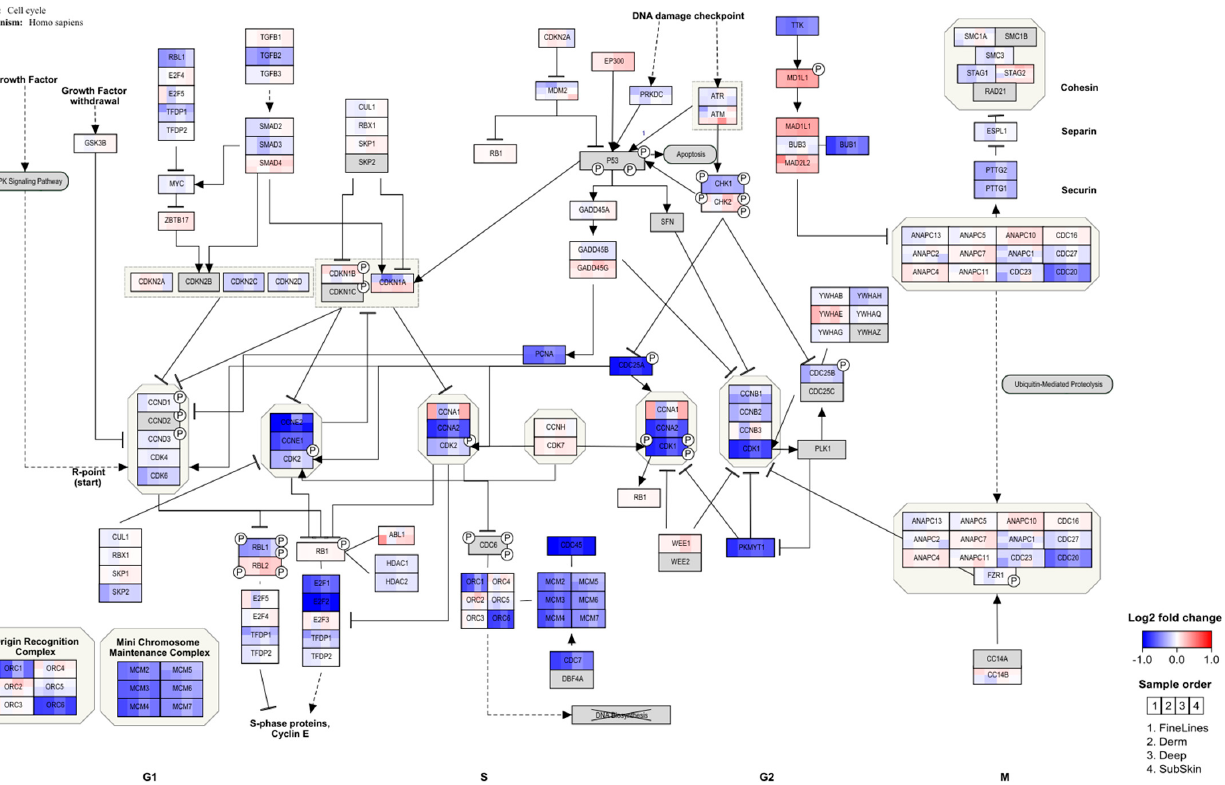
Figure 4. Visualization of the gene expression changes for M0 macrophages derived from THP-1 cells exposed to Perfectha ® filler extracts on the cell cycle pathway. Cells were exposed for 24 h to extracts of the various HA fillers. At 24 h, the cells were harvested and RNA isolated for cDNA preparation and microarray gene analysis.